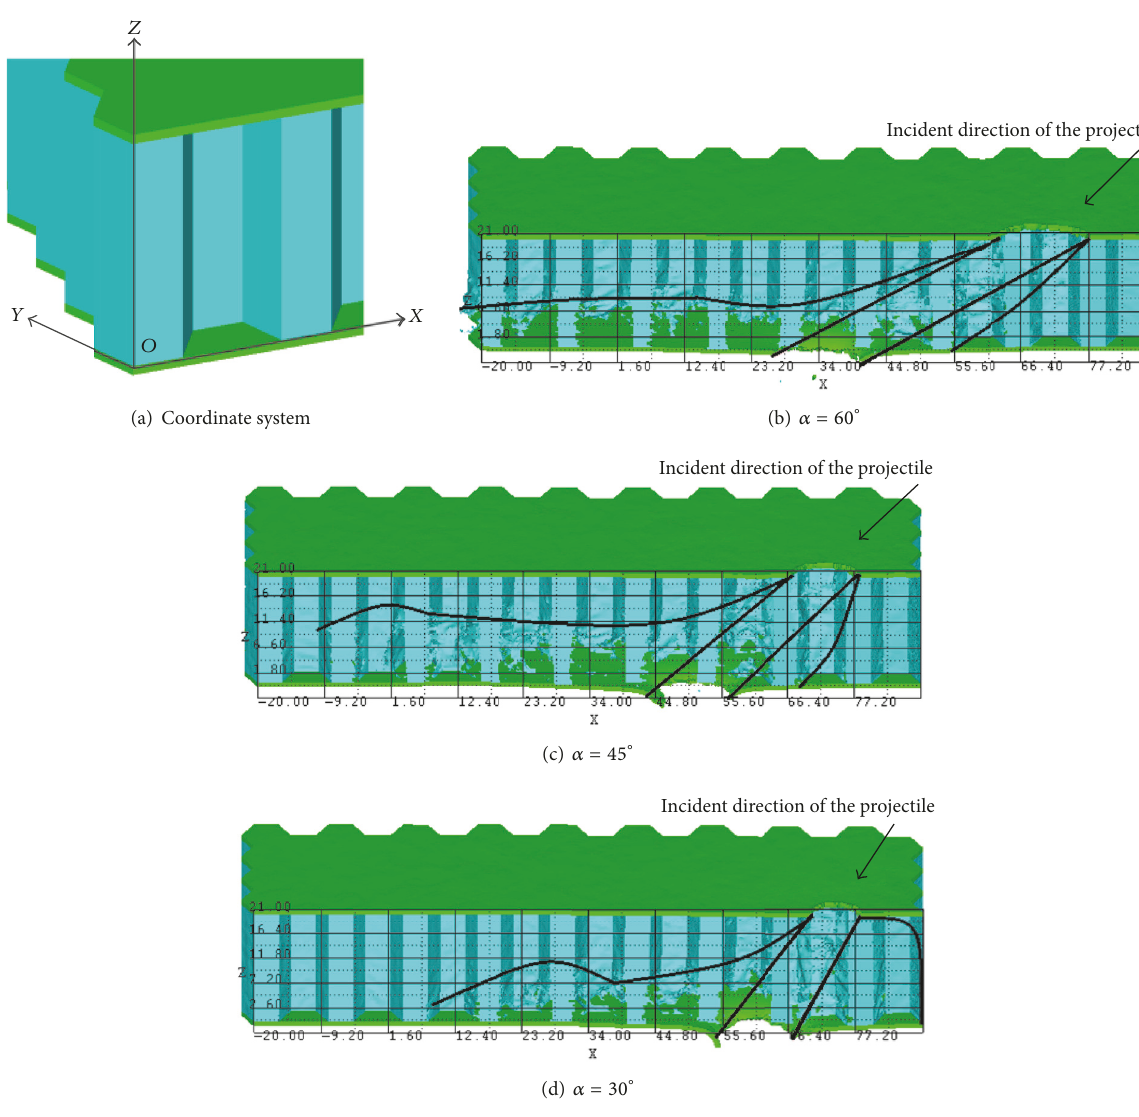
Figure 5: Damage of the first layer of honeycomb sandwich panel.